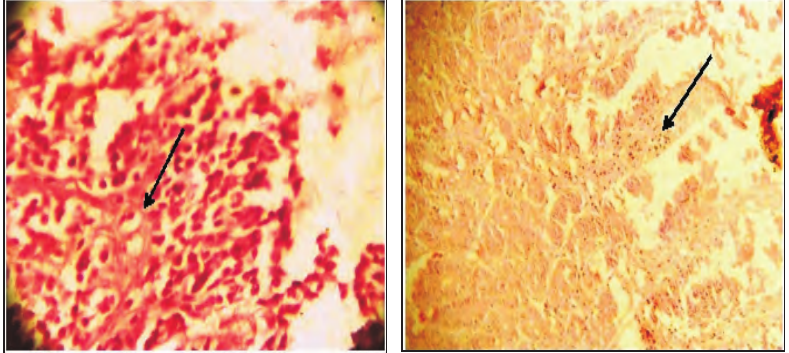
Figure-1. Photograph showing haemorr- hagic changes, necrosis and loss of villi in intestine of rats of group-I (H&E X 400)